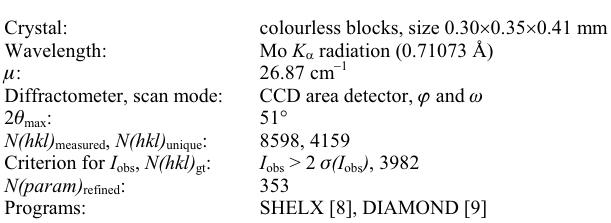
Table 1. Data collection and